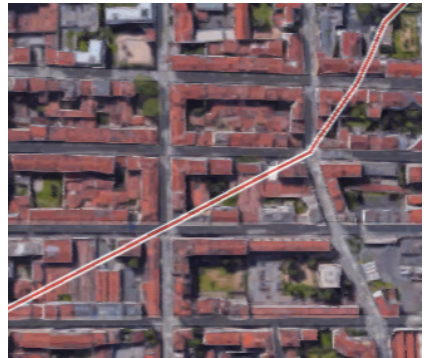
Figure 3. Example of borderline between two adjacent cities (Lyon and Villeurbanne) cutting city-blocks and buildings into two different parts.